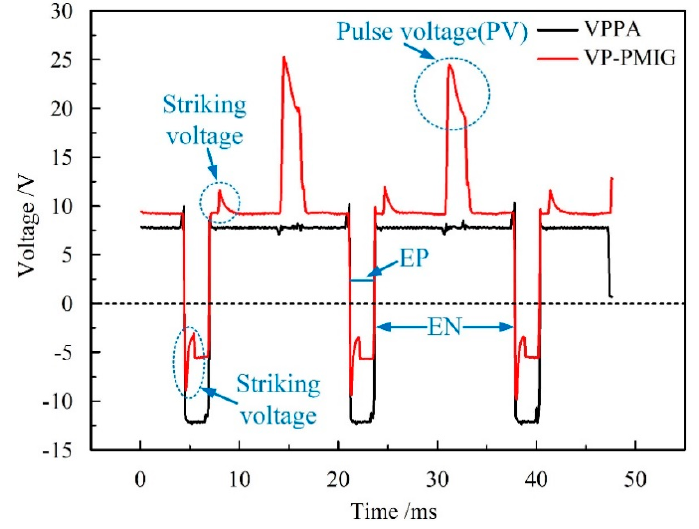
Figure 2. The VPPA and VP-PMIG arc voltages measured in a preliminary experiment.